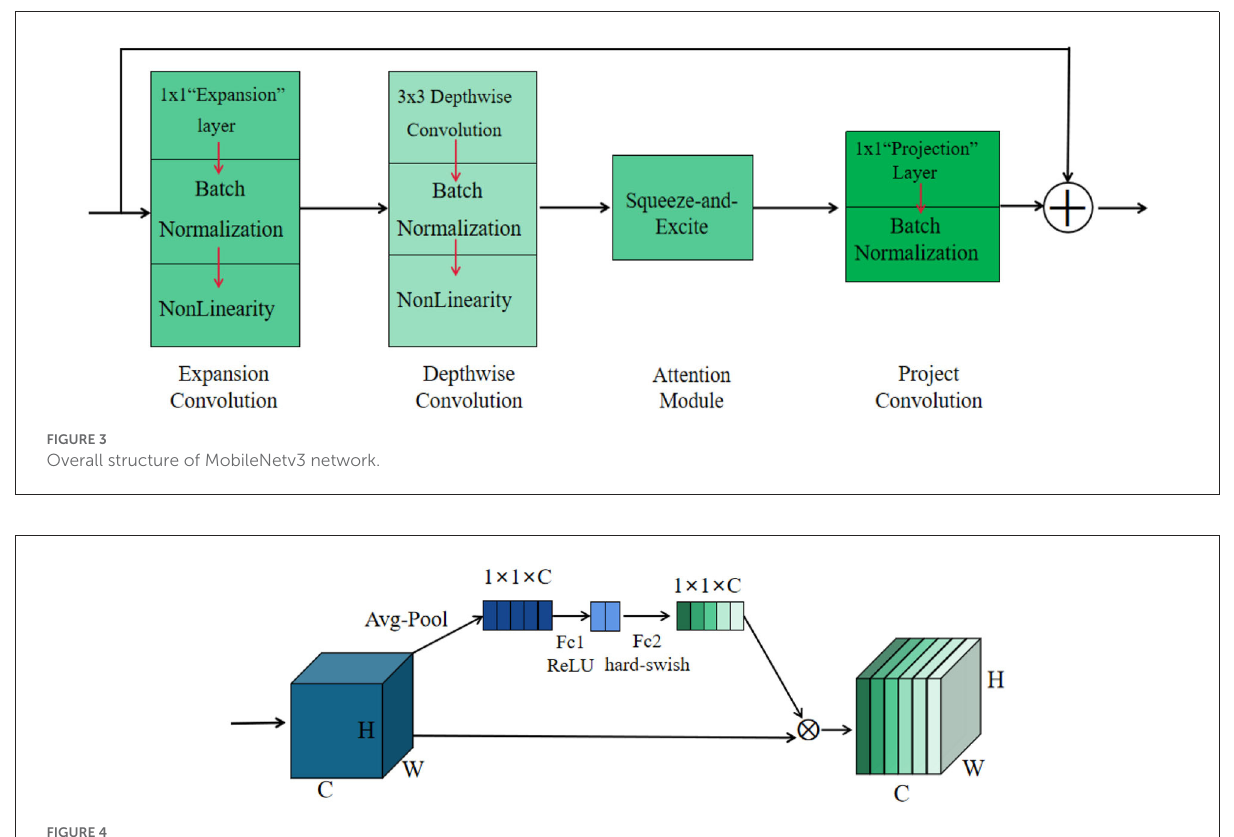
FIGURE4 Overall structure of